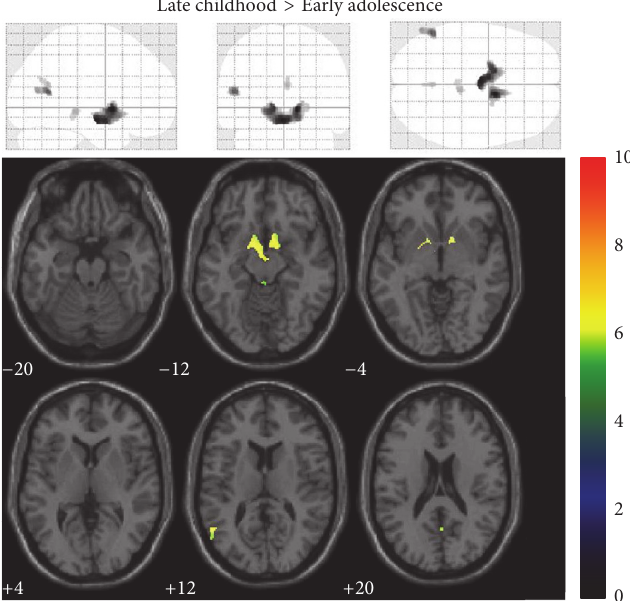
Figure1: Latechildhood minusearly adolescence statisticalparametricmapping. Traditionally presented z -scoremap (height threshold,0.05; extent threshold, 50) for the gray matter voxel reductions observed between late childhood and early adolescence (upper). Voxels showing significant changes in gray matter mapped onto a normalized structural image in the axial plane (lower).